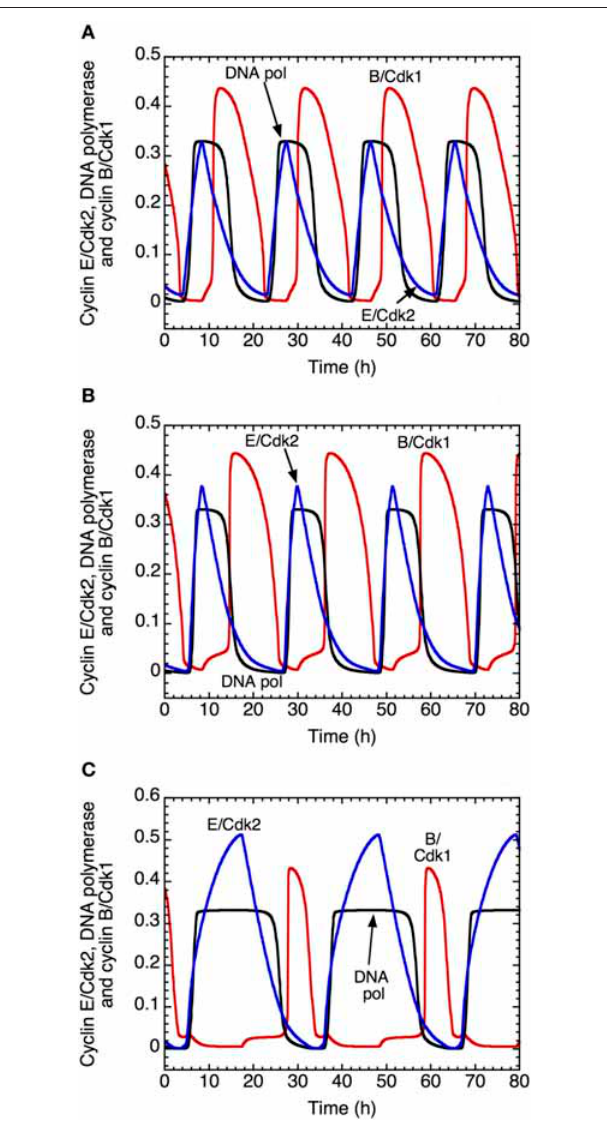
FIGURE 9 | Effect of the DNA replication checkpoint on Cdk oscillations in the detailed model for the Cdk network driving the mammalian cell cycle. The time evolution of cyclin E/Cdk2 (in blue), DNA polymerase α (in black) and cyclin B/Cdk1 (in red) is shown (A) in the absence of activation of the kinase ATR driving the DNA replication checkpoint, with k aatr = 0, or in the presence of low (B) or strong activation (C) of the kinase ATR, with k aatr = 0 . 01 μ M − 1 .h − 1 in (B) and 0.024 μ M − 1 .h − 1 in (C) . The presence of the DNA replication checkpoint slows down the progression in the cell cycle: the period of the cell cycle clock passes from 19h in (A) , to 21.6h in (B) and 31h in (C) . Moreover, the DNA replication checkpoint improves the separation between the phase of DNA replication, represented by the peak of DNA polymerase α and the phase of mitosis, represented by the peak of cyclin B/Cdk1. Other parameter values are as in Table S2 in Gérard and Goldbeter